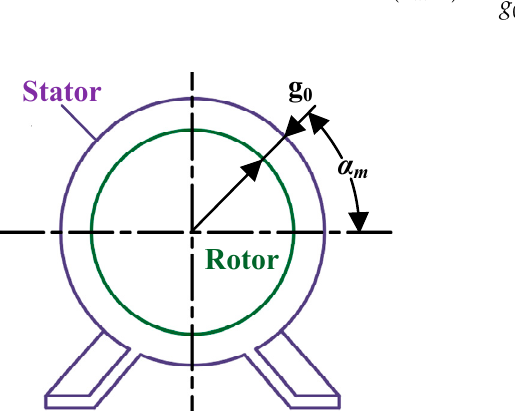
Figure 2. Air gap distribution under normal generator operating conditions.